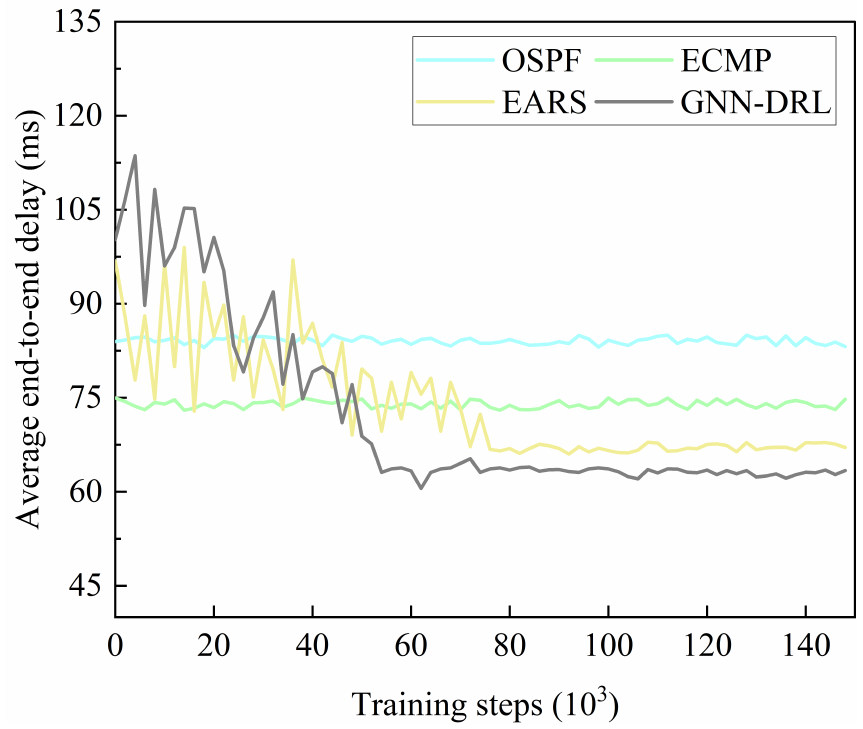
Figure 9. Optimization effect of average end-to-end delay under 80 Mbps traffic